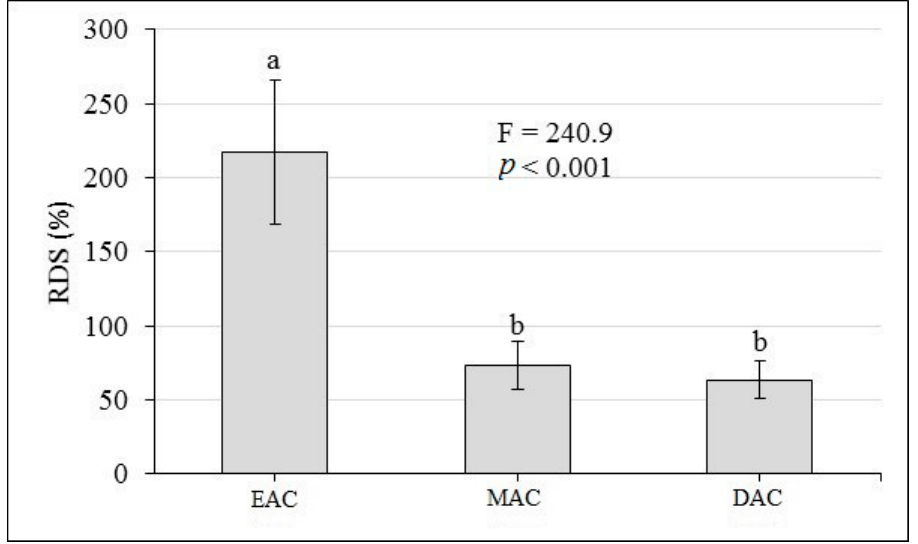
Figure 3. RDS (Downed logs/Snag) in the human accessibility classes: EAC = easy accessibility class, MAC = medium accessibility class, and DAC = difficult accessibility class.